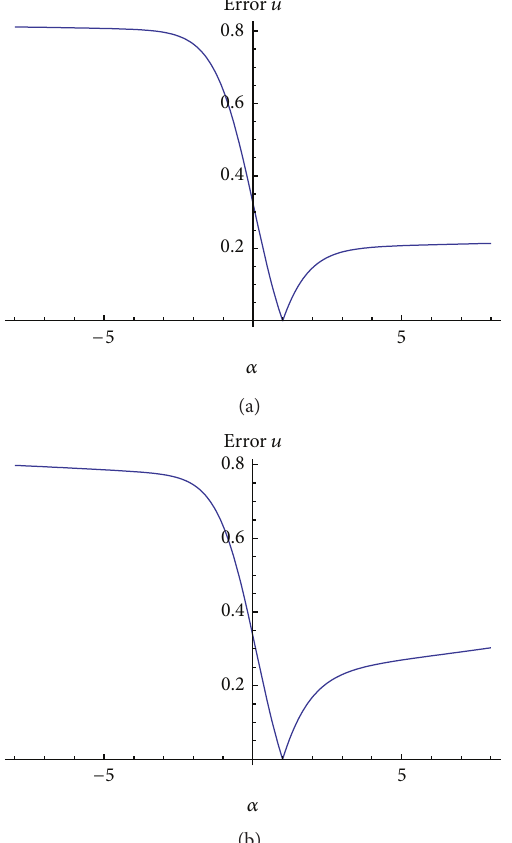
(3, 0.1)| , (b) absolute app